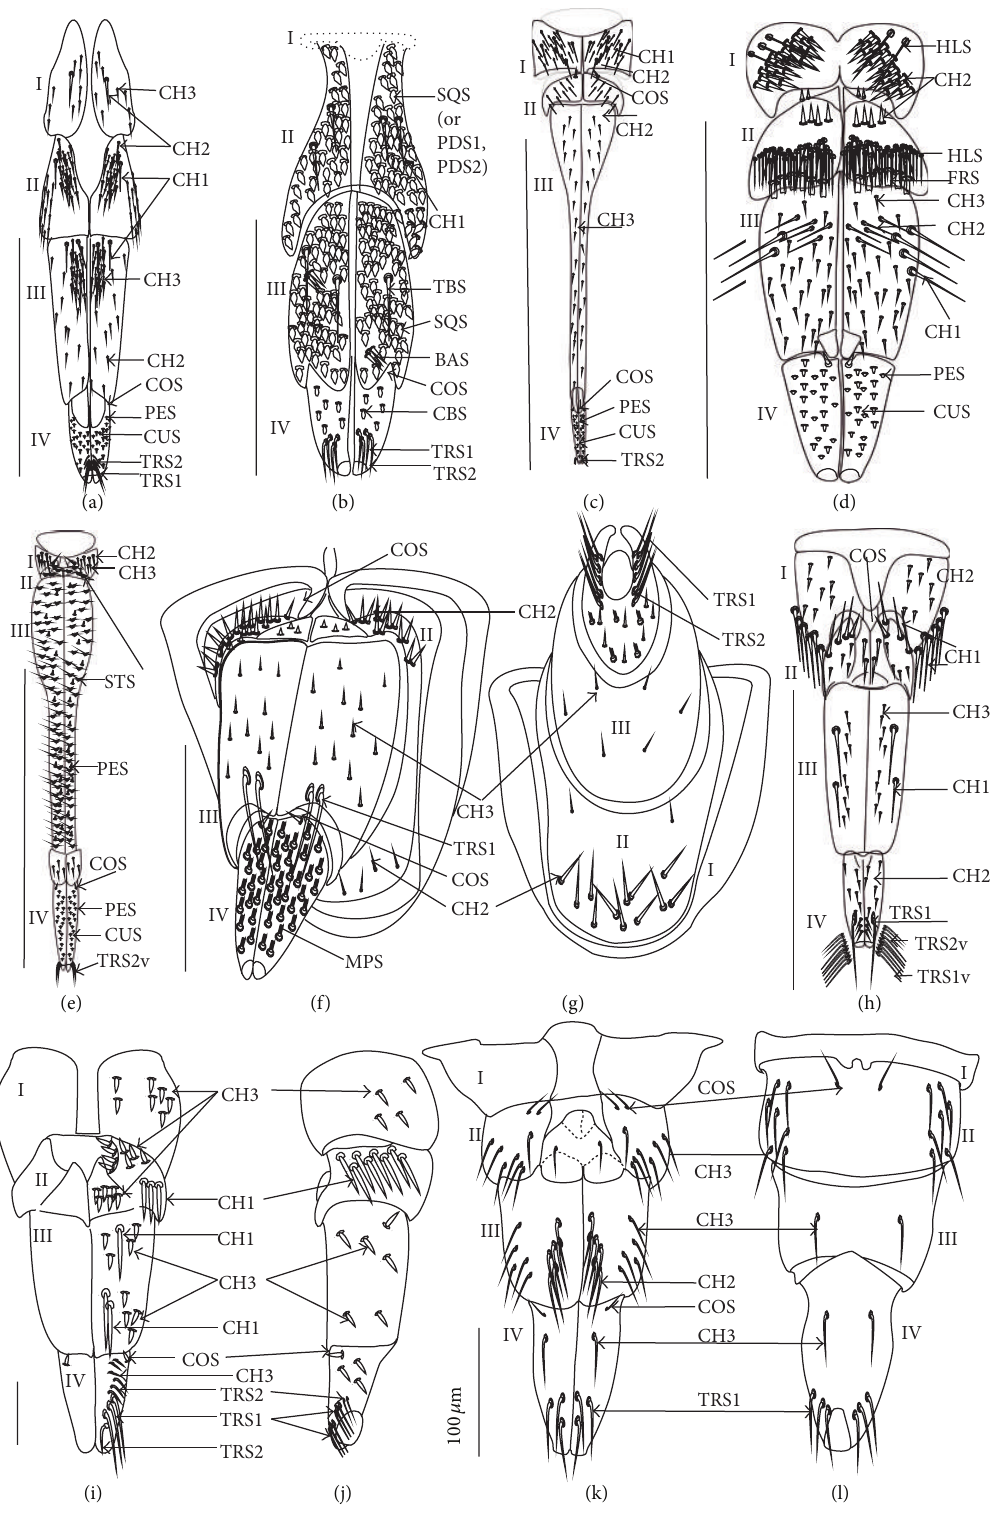
Figure 7: Types of distribution of the mechanosensilla on the labial segments in the Nepomorpha (except for the Corixoidea). Sensilla numerous, grouped, and unevenly arranged on the labium ((a) Belostomatidae). Sensilla densely and evenly arranged on the labium ((b) Nepinae, Ranatrinae: I segment reduced dorsally); ((c) Ochteridae); ((d) Gelastocorinae). Sensilla less numerous and numerous evenly arranged ((e) Aphelocheiridae); ((f) dorsal side (g) ventral side of Cheirochelinae, Laccocorinae, Limnocorinae, Cryphocricinae, and Naucorinae). Sensilla are not very numerous and scattered unevenly ((h) Notonectinae); ((i) dorsal side, (j) lateral side of Pleidae); ((k) dorsal side, (l) ventral side of